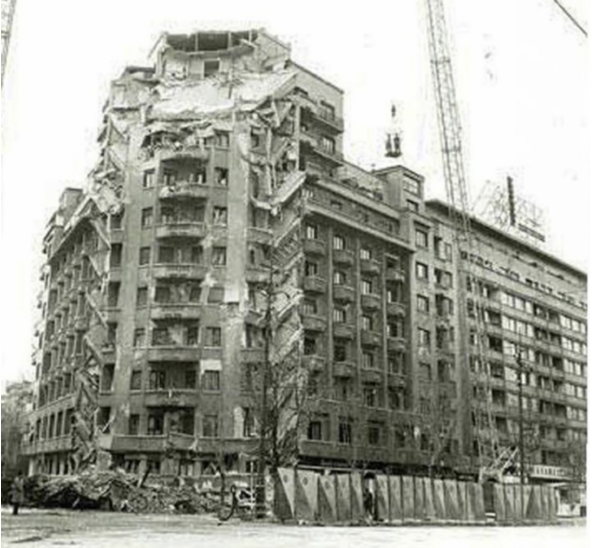
Figure 7. Wilson block of flats after earthquake (1977). Source: courtesy of Rezisten¸ta urban˘a (Urban resistance).